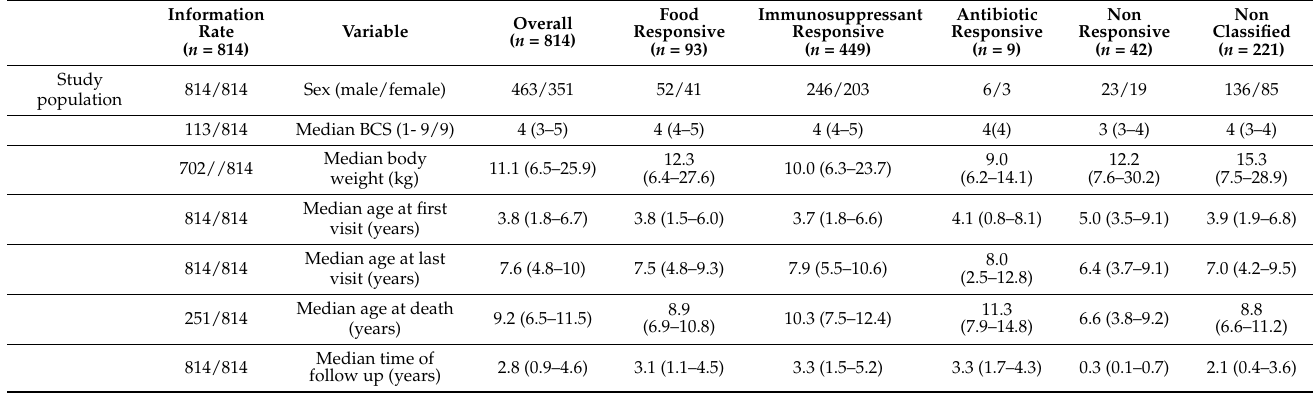
Table 1. Summary of signalment variables, presenting signs, and follow up information by treatment outcome